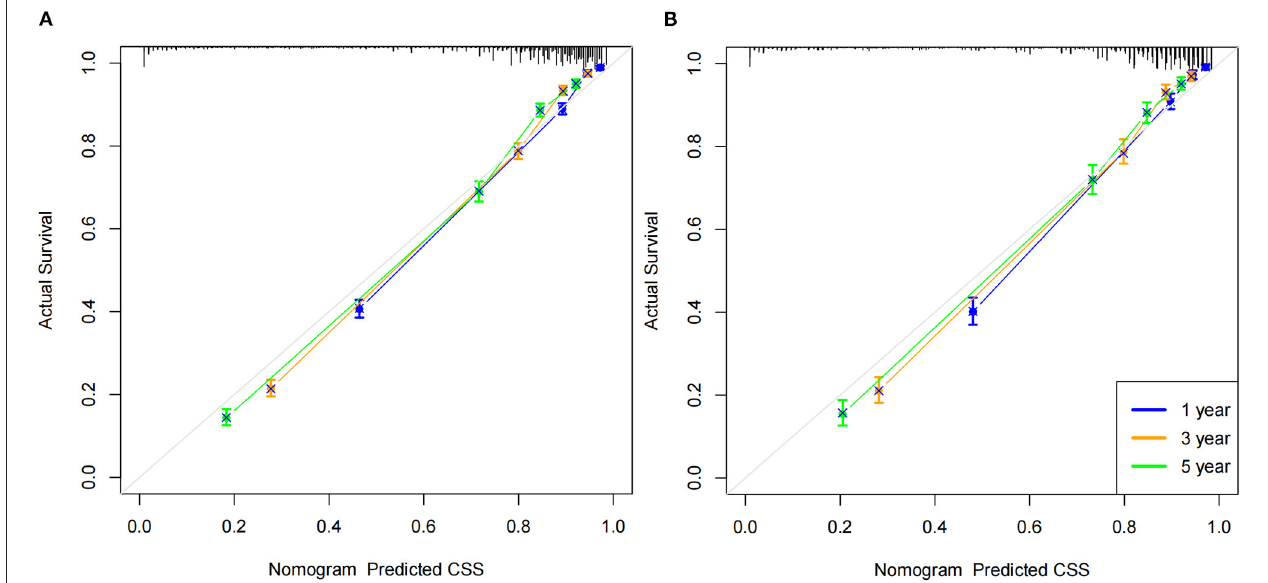
FIGURE 3 | Calibration curve of the nomogram. (A) Calibration curves of 1 -, 3 - and 5-year CSS in the training cohort; (B) calibration curves of 1-, 3-, and 5-year CSS in the validation cohort.